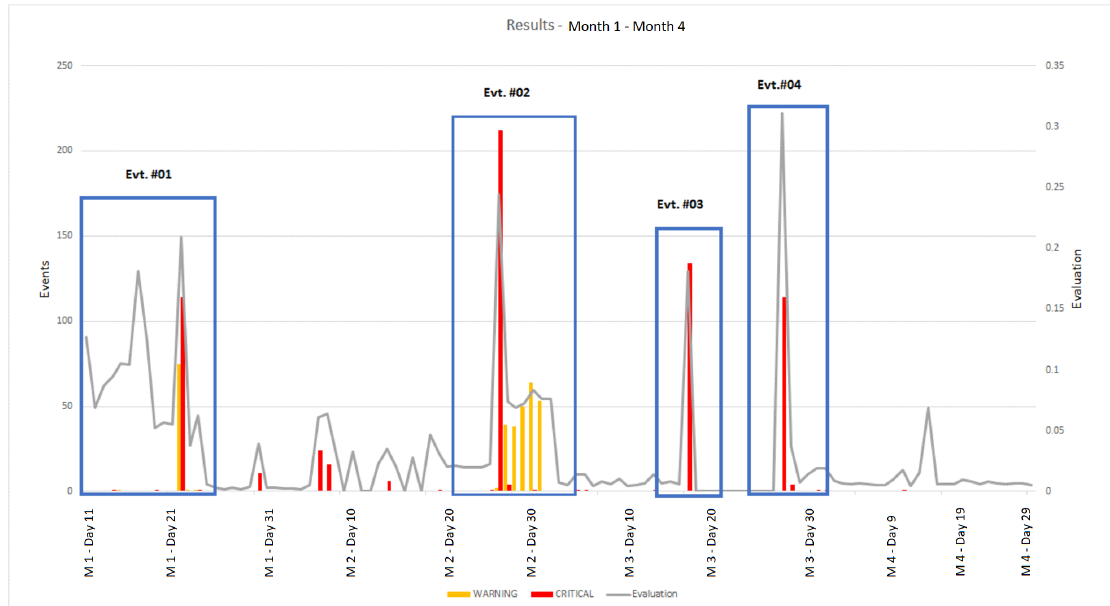
Figure 9. Aggregated evaluation graph and relevant events (production scenario—M1 till M4).